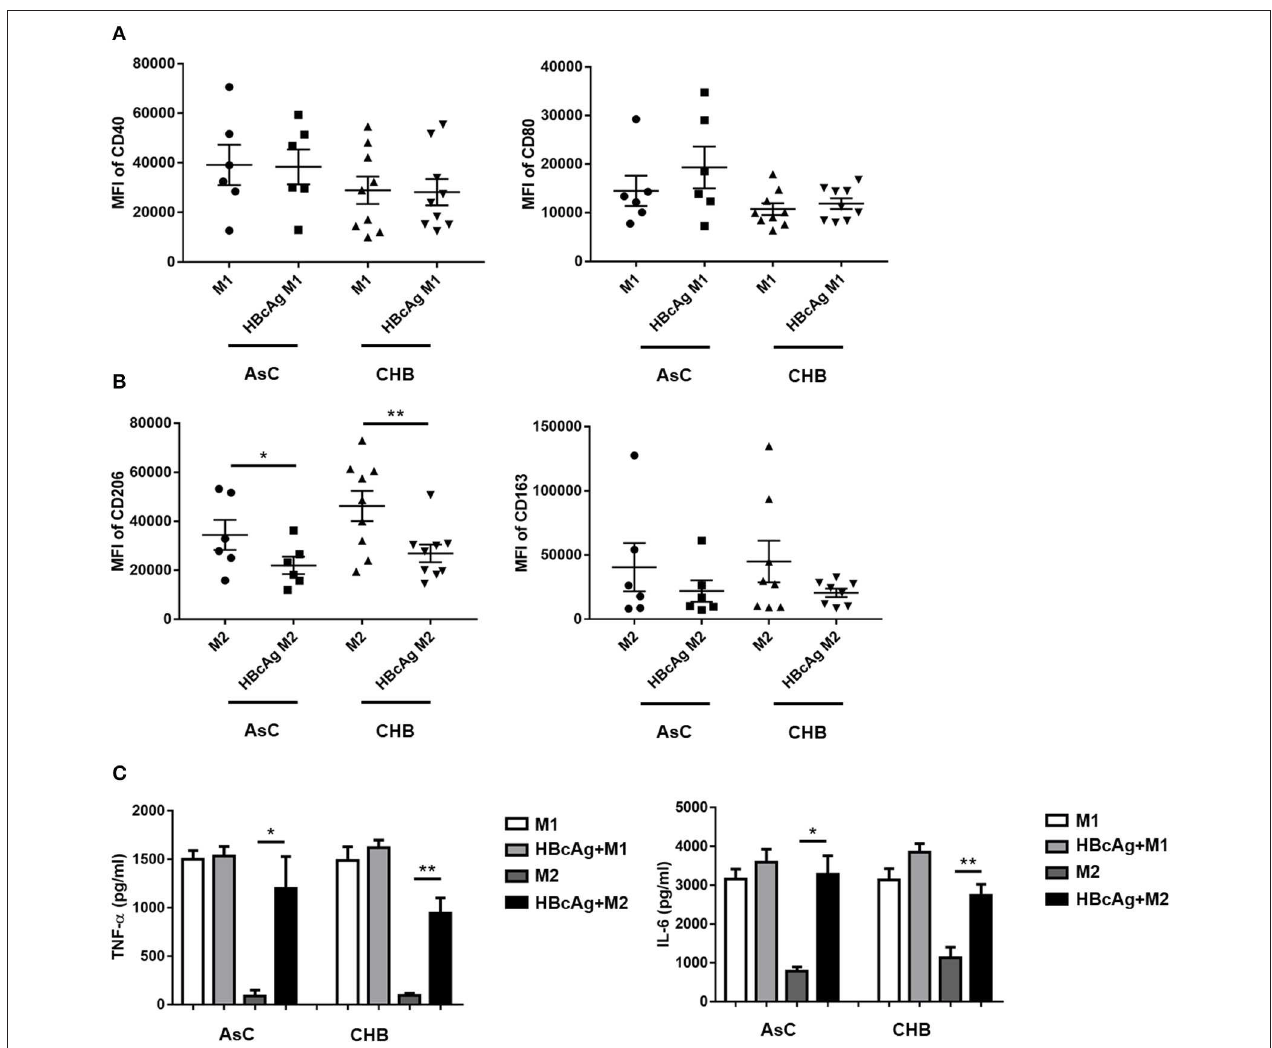
FIGURE 7 | Monocyte-derived macrophages of patients with HBV infection presented a diminished M2 subtype and enhanced pro-inflammatory property under HBcAg stimulation. (A–C) 10 µ g/ml HBcAg or an equal volume of PBS was added simultaneously with LPS/IFN- γ or IL-4 to unpolarized M1 or M2 M Φ from HBV-infected patients and incubated for an additional 24h for further polarization. (A) Cumulative results showing CD40 and CD80 expression levels in M1 M Φ stimulated with either PBS or HBcAg from asymptomatic HBV carriers (AsC, n = 6) or patients infected with chronic hepatitis B (CHB, n = 9). (B) Cumulative results showing CD206 and CD163 expression levels in M2 M Φ stimulated with either PBS or HBcAg from asymptomatic HBV carriers (AsC, n = 6) or patients infected with chronic hepatitis B (CHB, n = 9). (C) Supernatants of polarized M1 and M2 M Φ from asymptomatic HBV carriers (AsC, n = 5) or patients with chronic hepatitis B (CHB, n = 5) were collected to measure TNF- α and IL-6 productions by ELISA after stimulated with HBcAg or PBS. Data were analyzed using a paired Student’s t -test. Results are shown as the mean ± SEM. * p < 0.05, ** p <